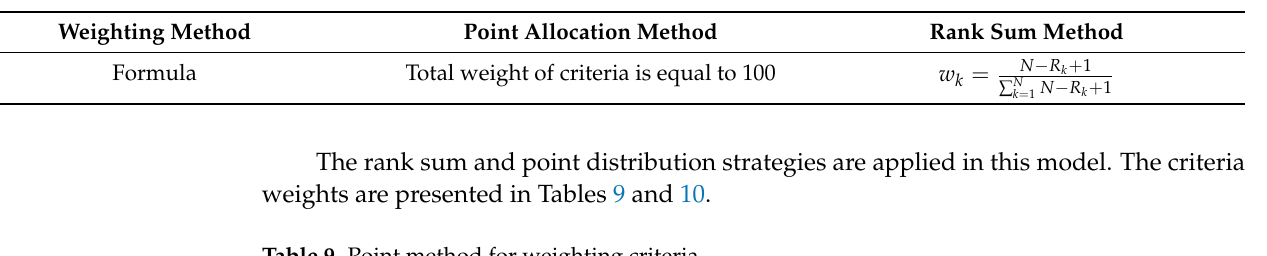
Table 9. Point method for weighting